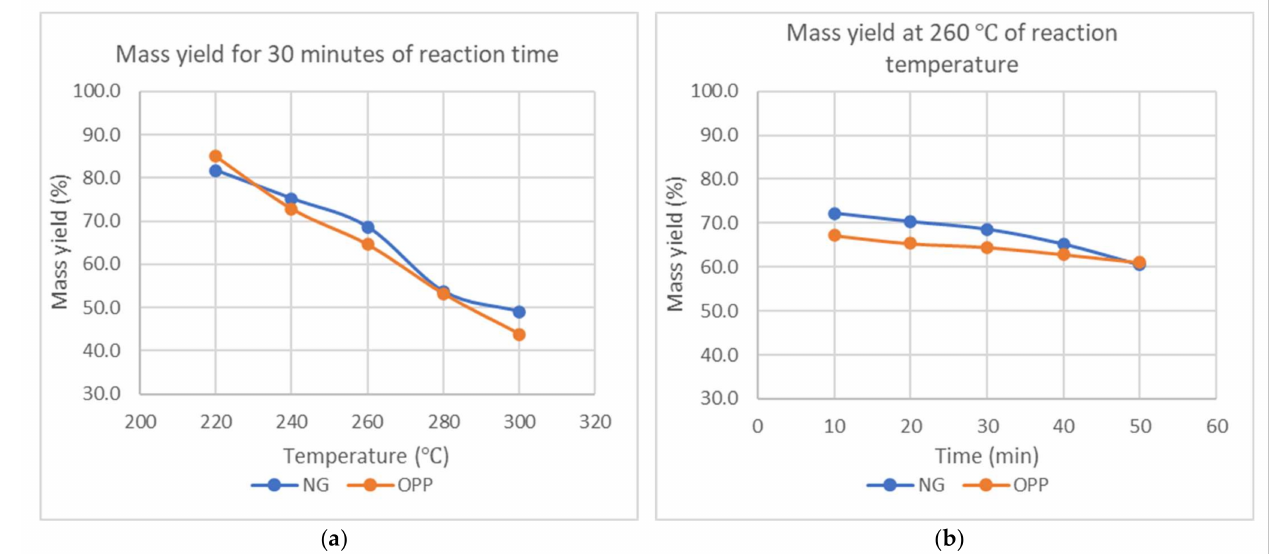
Figure 6. Mass yield ( a ) against temperature at constant reaction time of 30 min and ( b ) against reaction time at constant temperature of 260 ◦